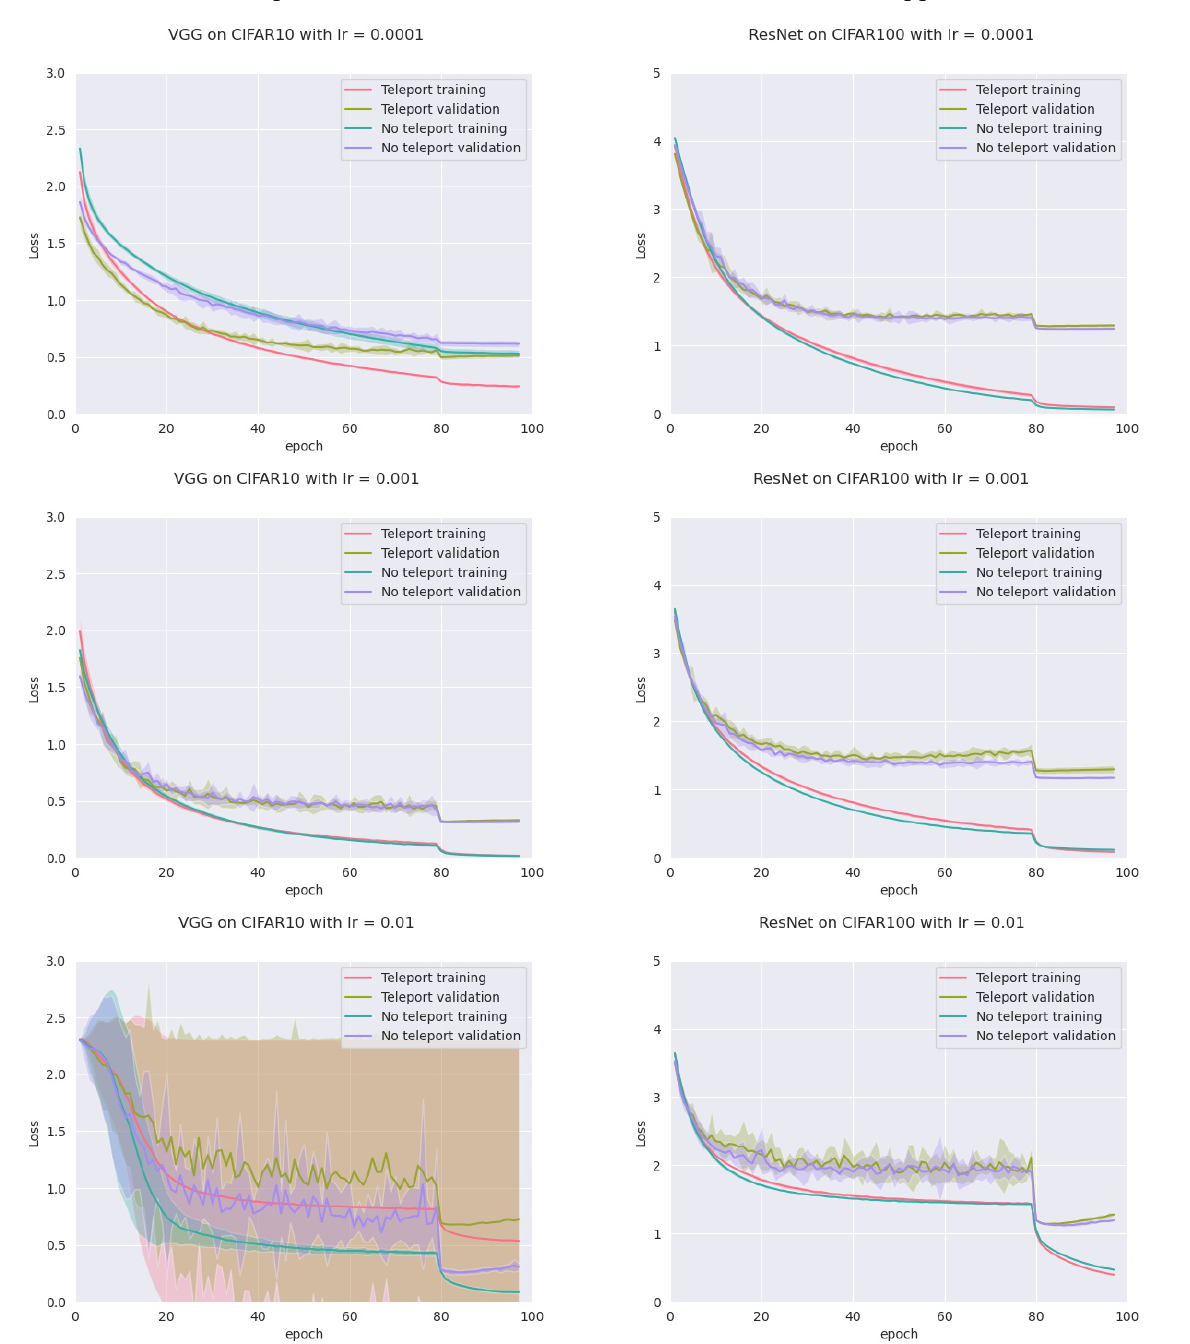
Figure 8. Average loss of VGG with normal initialization on CIFAR10 ( left ) and ResNet with xavier initialization on CIFAR100 ( right ) both traing with SGD with momentum over 5 experiments for each, with and without teleportation, at the beginning of the training with CoB of 0.9. Learning rate increases from top to bottom rows. We also show a shadow around the average curves at two times the standard deviation over the five